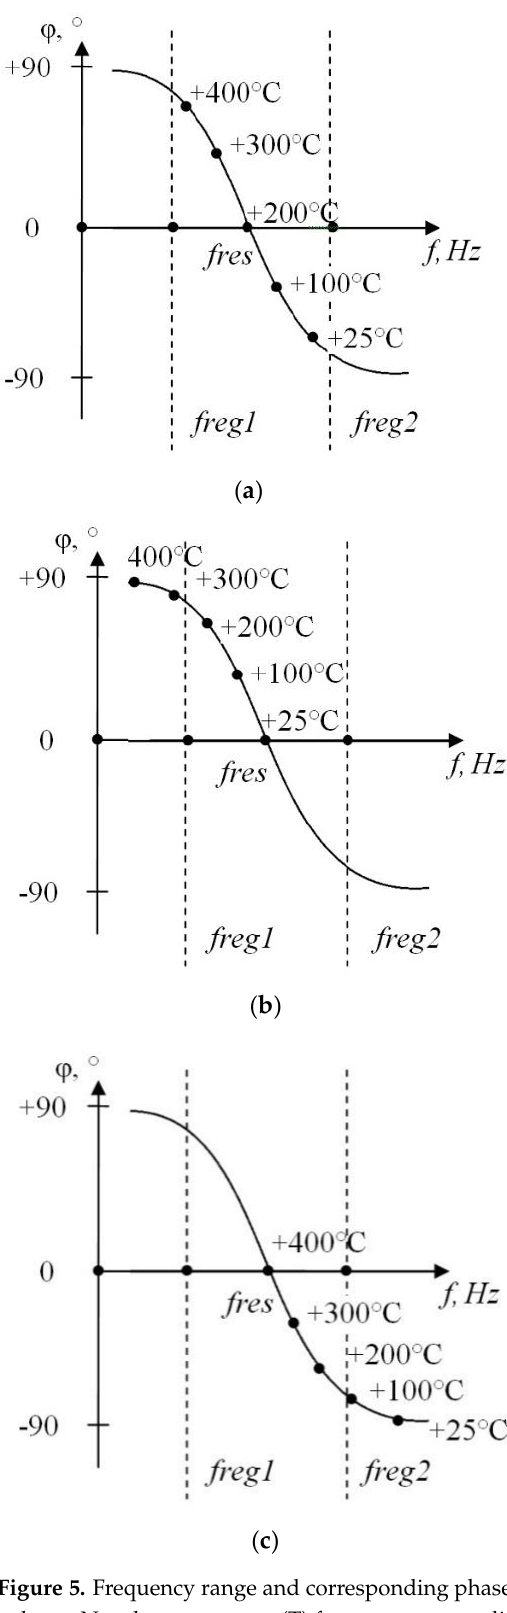
Figure 5. Frequency range and corresponding phase shift between inductor (L1) current and output voltage. Nozzle temperature (T) for resonance condition. ( a ) T = 200 °C, ( b ) T = 25 °C, ( c ) T = 400 °C.